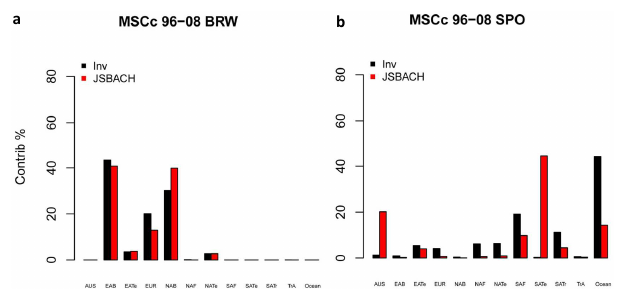
Fig. A2. Regional contribution to the mean seasonal cycle in the stations of Barrow (BRW) and South Pole (SPO), expressed as per- centage contribution. For the region labels refer to Fig. 1.